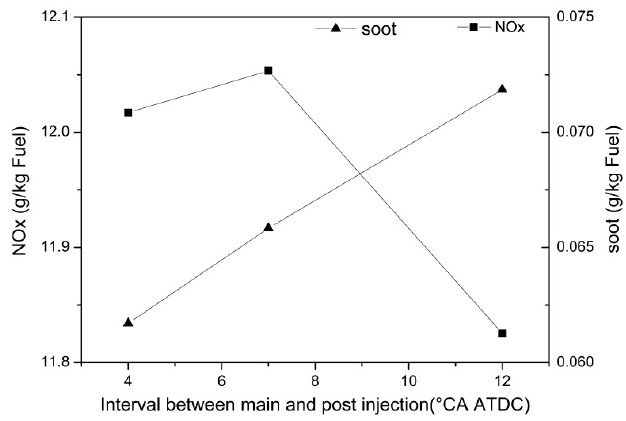
Figure 12. Comparisons of NO x and soot emissions under the cases of assigned EGR stratification with different interval crank angle between main and post injection.